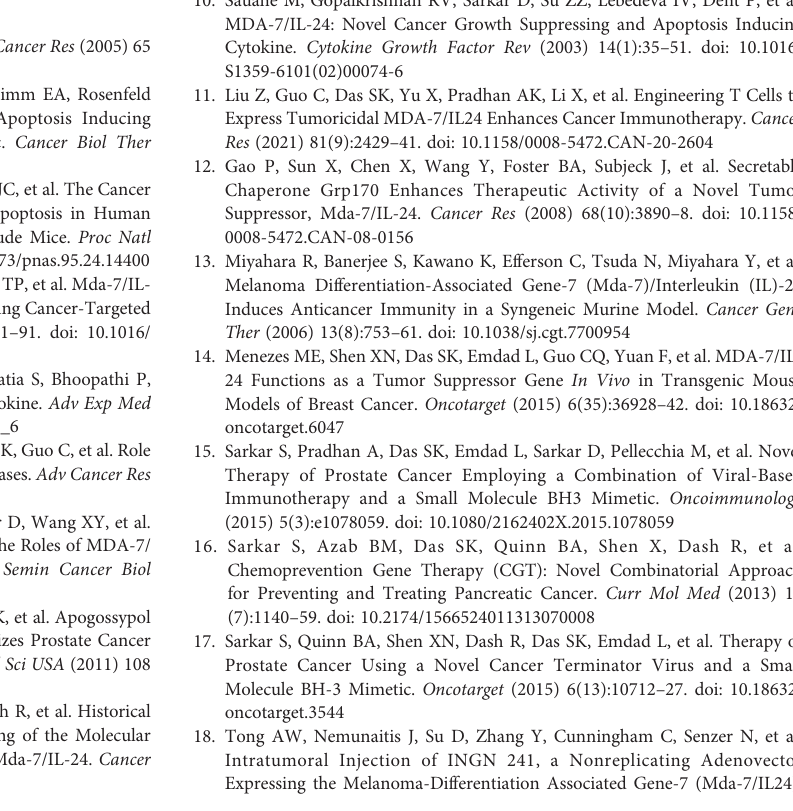
Supplementary Figure 1 | Effect of Insulin signal peptide (SP) on IL-2 secretion: Canonical IL-2 SP was swapped with the Insulin SP through standard cloning.